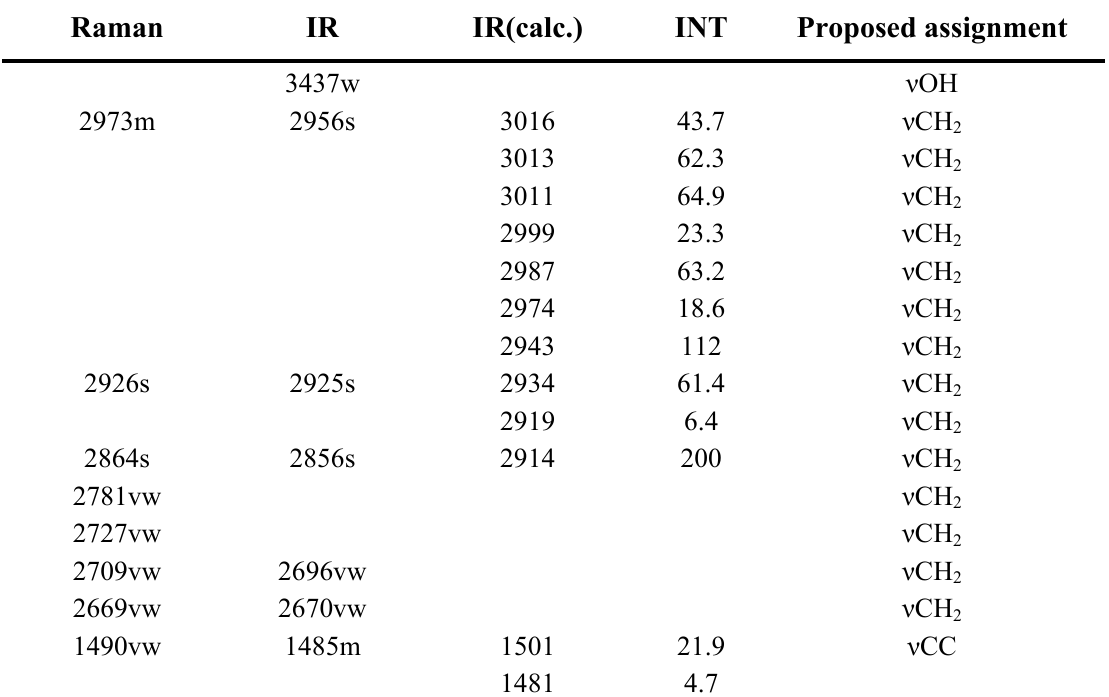
Table 2. FTIR and Raman frequencies of N,N -dioctylazepanium bromide ( 1 ). Raman IR IR(calc.) INT Proposed